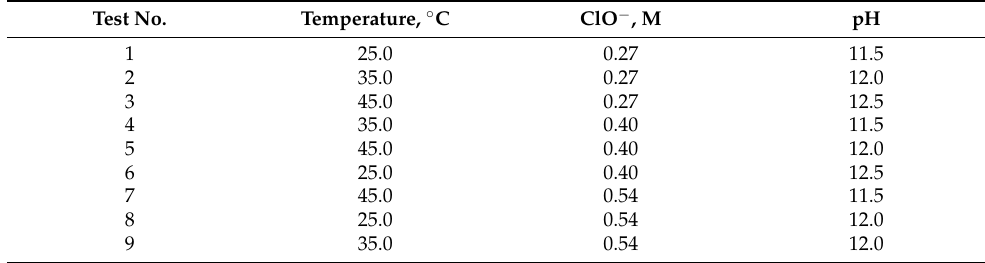
Table 4. Taguchi experimental design (L 9 ) to determine the optimal combination of leaching with sodium